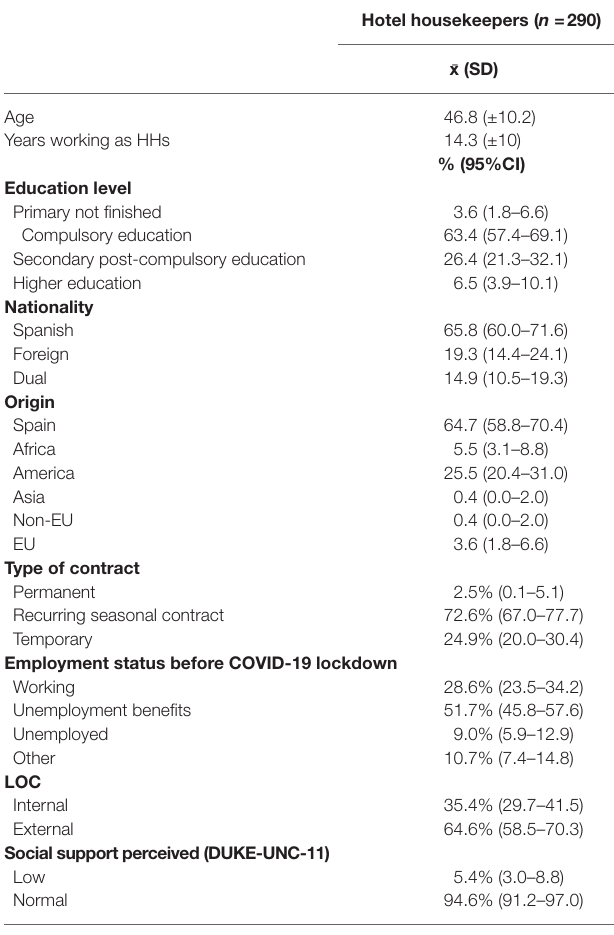
TABLE 1 | Characteristics of the study